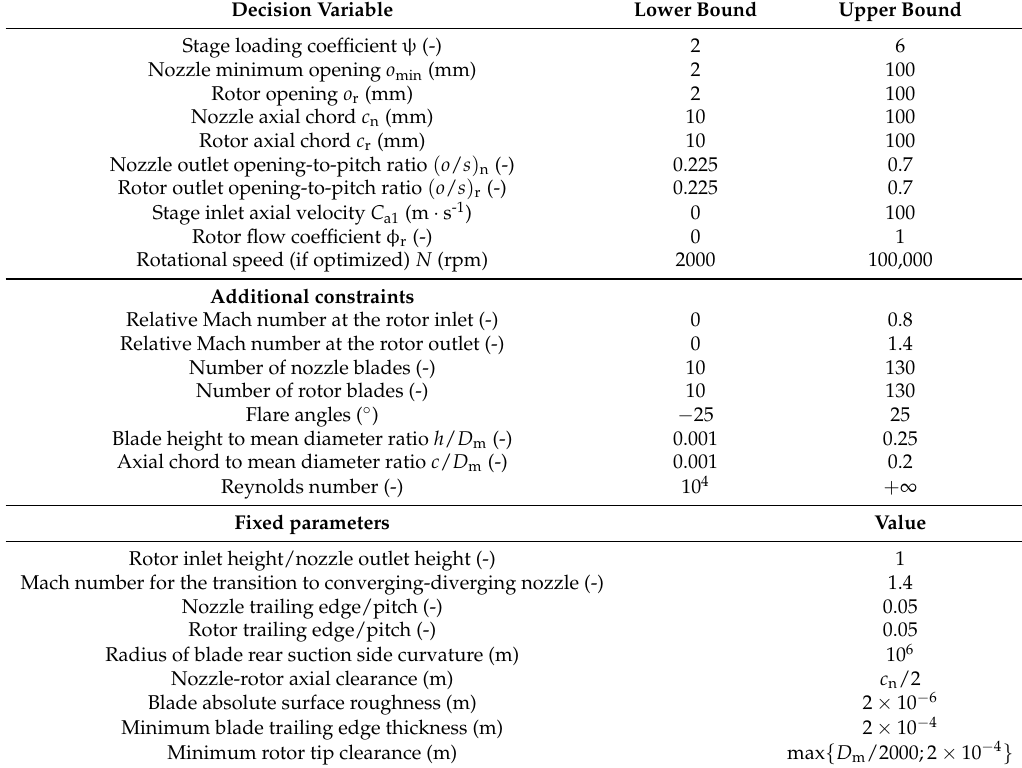
Table 1. Lower and upper bounds for the decision variables, constraints and fixed